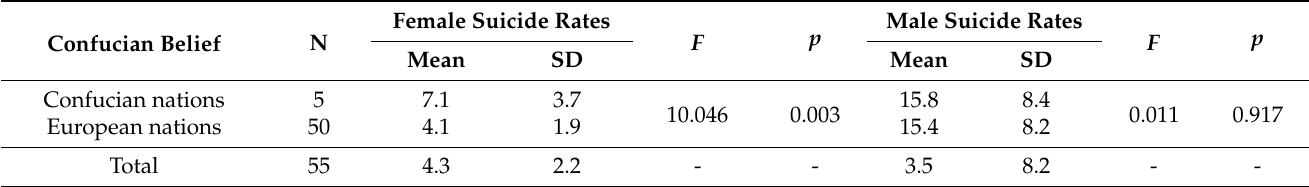
Table 5. Comparison between the Confucian and European countries in the suicide rates of males and